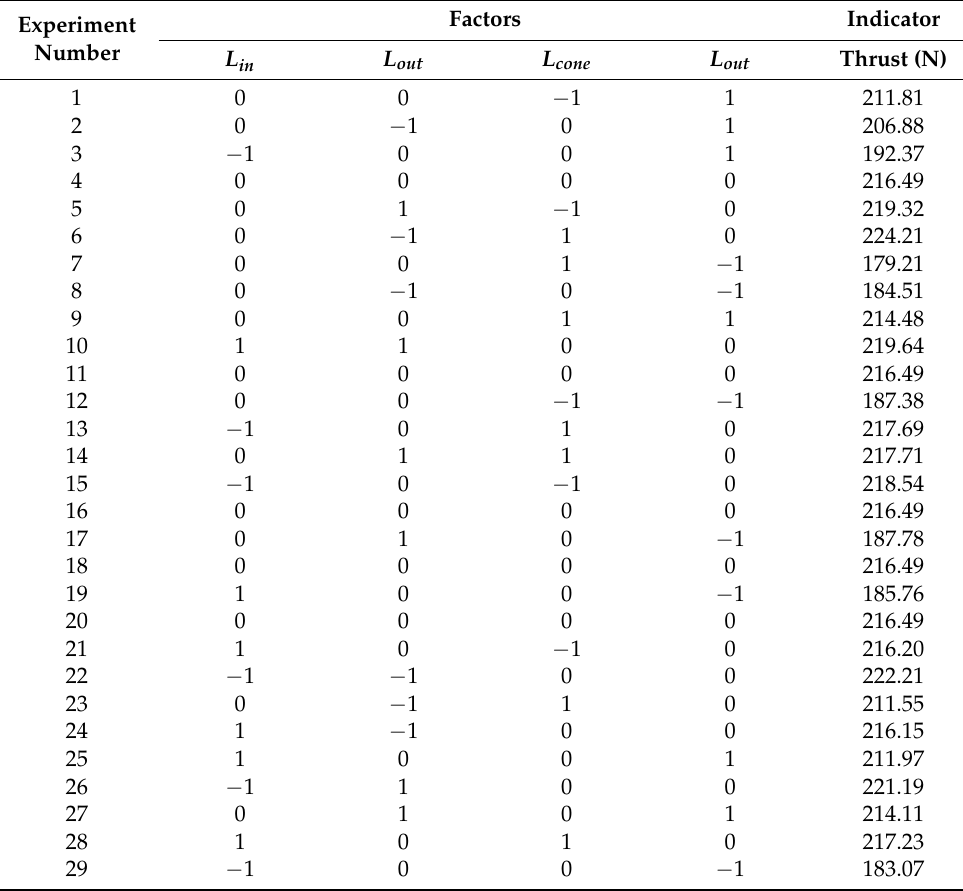
Table 4. RSM experiment combination and